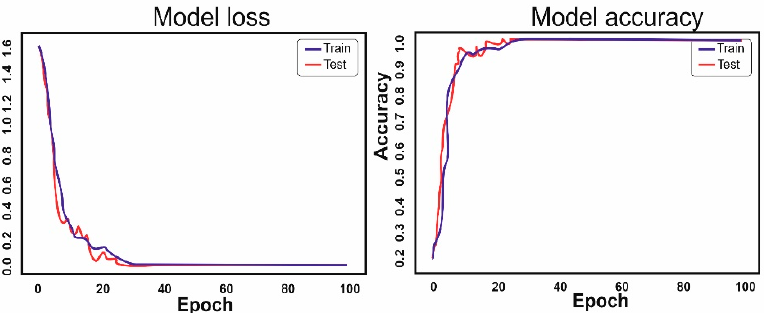
Figure 7. Graphs of the loss function and accuracy of boxers with 2–3 years of training experience.